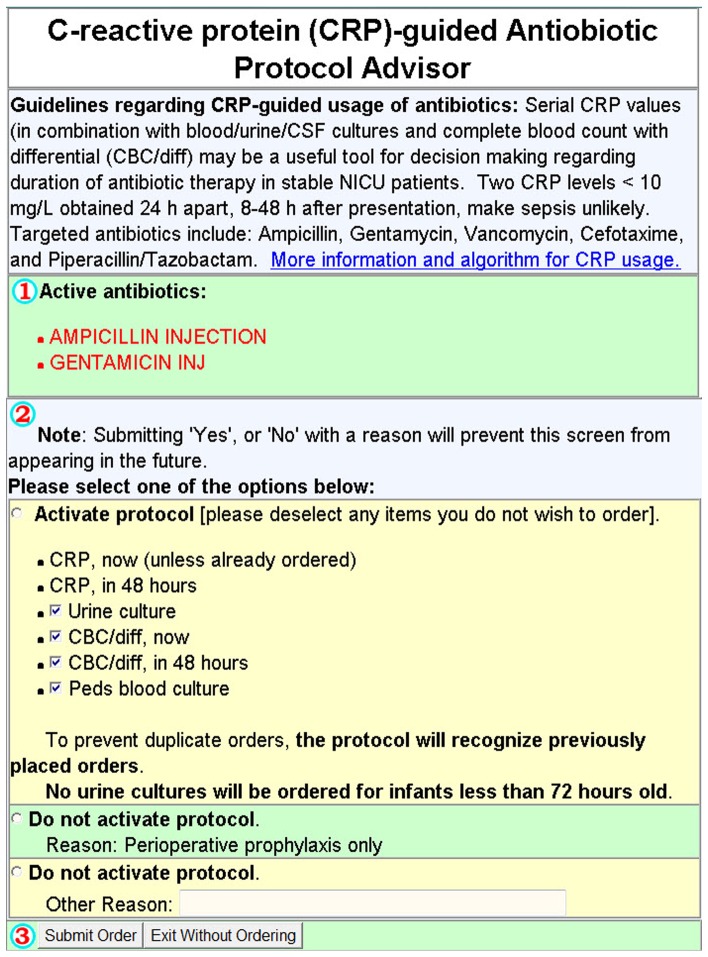
Screenshot CRP protocol.Entry of an antibiotic order into the computerized system produced this screen, prompting the initiation of the CRP protocol. The protocol included automated orders for a blood culture, CRP, and WBC with differential at admission, followed by a repeat CRP and WBC with differential 48